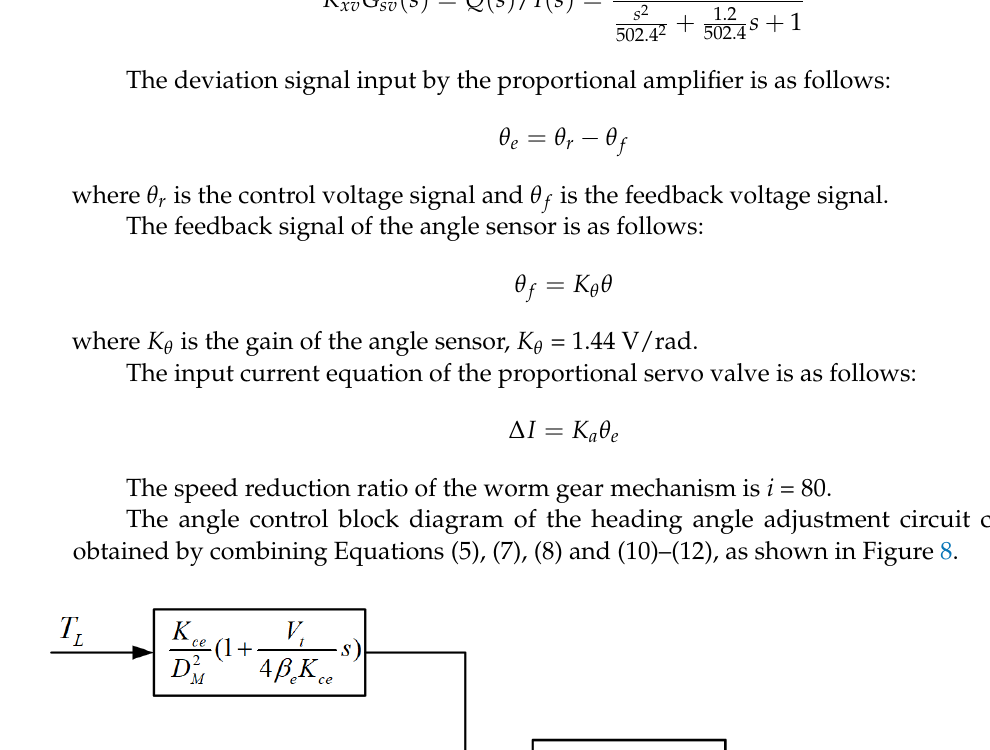
diagram of the system can be simplified as Figure